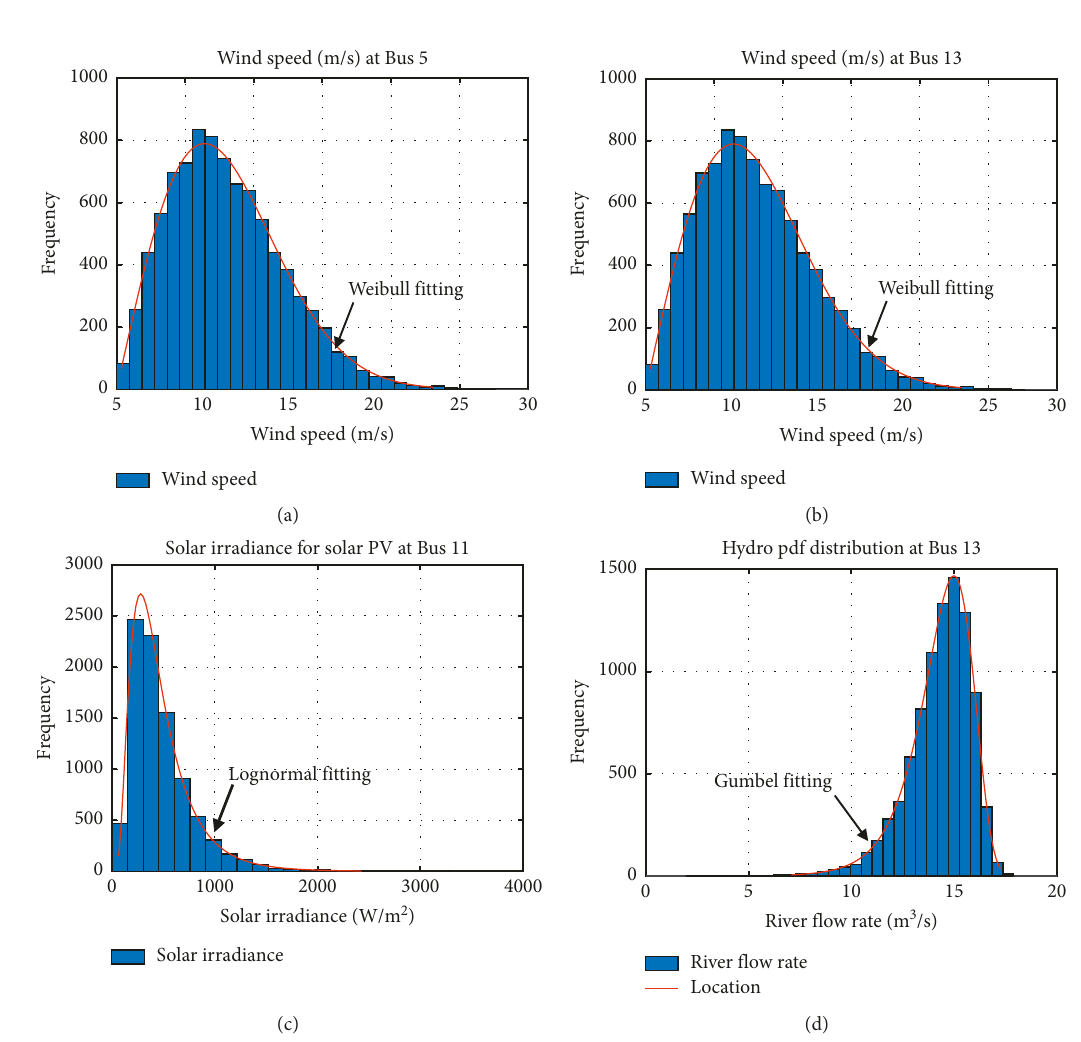
Figure 1: PDFs at (a) Bus 5 Wind, (b) Bus 13 Wind, (c) Bus 11 Solar, and (d) Bus 13